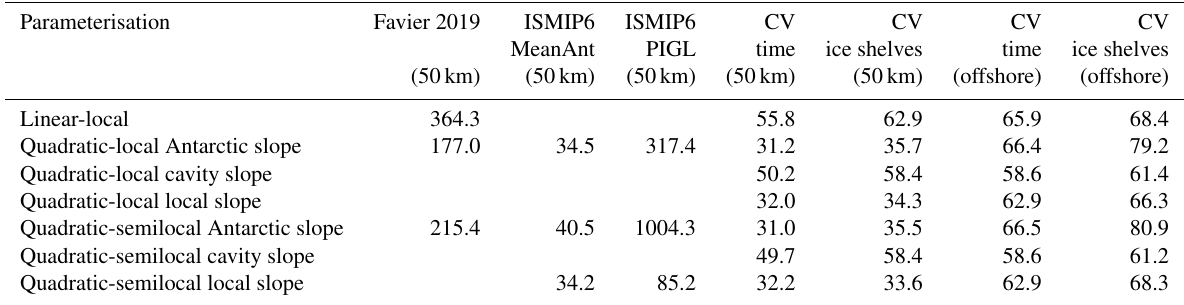
Table 3. Root-mean-squared error (RMSE int ) between the reference (NEMO) and parameterised (simple parameterisations) yearly integrated ice-shelf melt [Gtyr − 1 ] over the 35 individual ice shelves and 127 simulation years using the parameters from Favier et al. (2019) and ISMIP6 (Jourdain et al., 2020). RMSE int over the synthetically independent evaluation dataset resulting from the cross-validation (CV) over time and the cross-validation over ice shelves. The first to fifth column are computed with input properties from the 50km domain. The sixth and seventh column show the cross-validation results using the input from the offshore domain. The RMSE int values combining offshore properties and parameters from previous studies are not shown because they are 1 to 3 orders of magnitude higher.